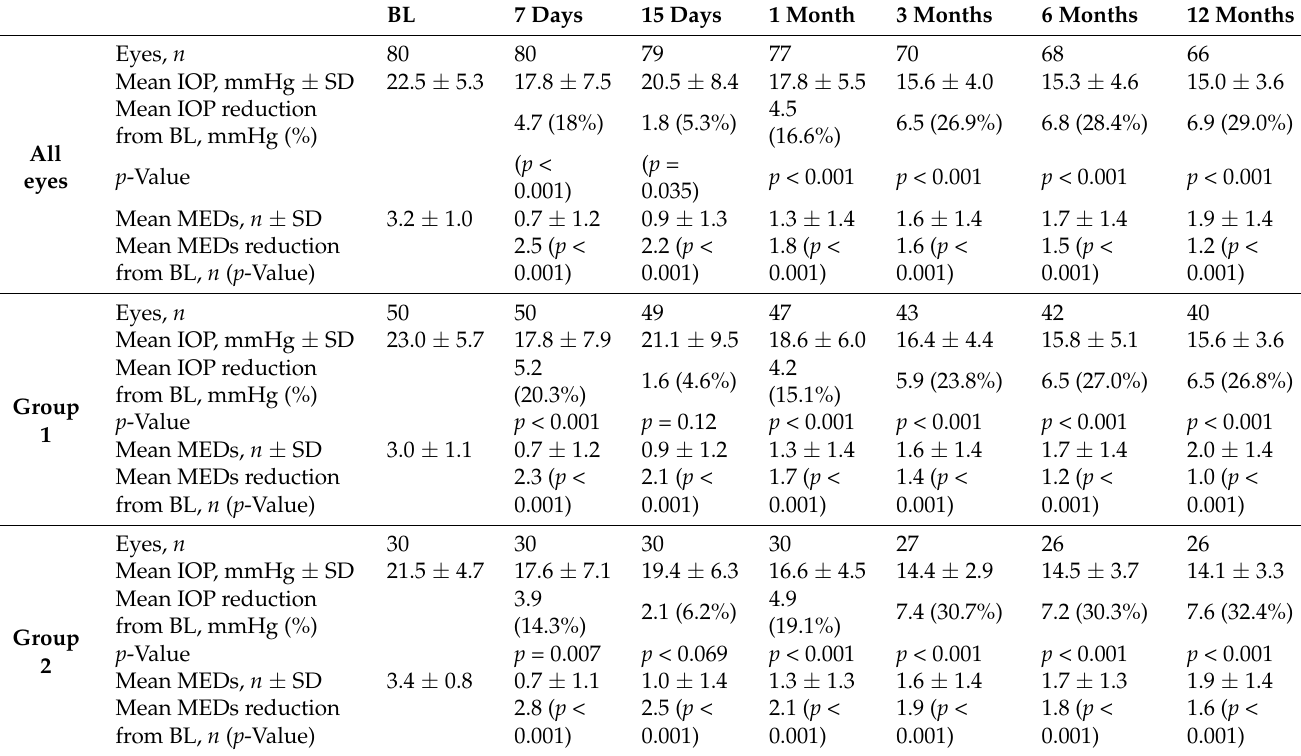
Table 2. Differences in intraocular pressure and antiglaucoma